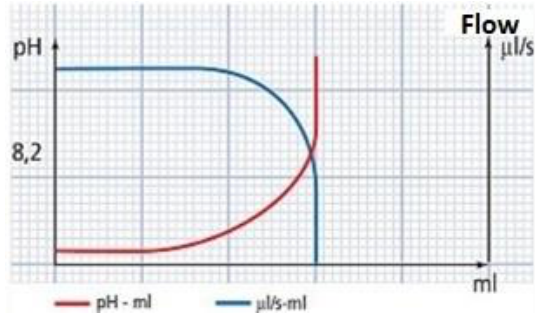
Fig. 2. Dosing near the endpoint pH/mV of the set endpoint [17] The tests were carried out using samples of the 5W30 fresh and used motor